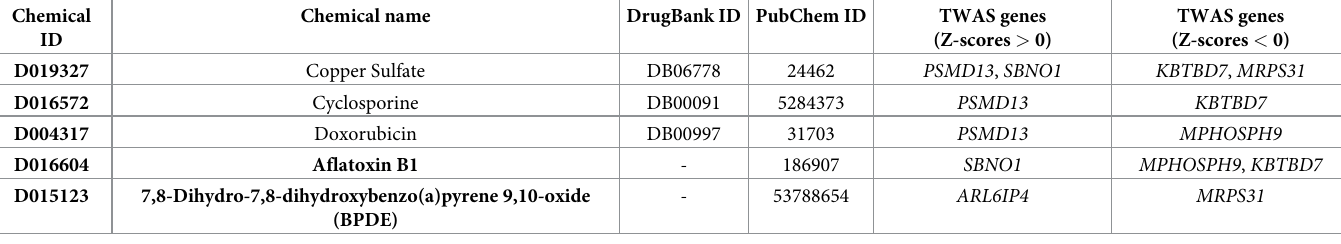
Table 2. A list of five toxic chemicals discovered based on CTD as potentially toxic chemicals for